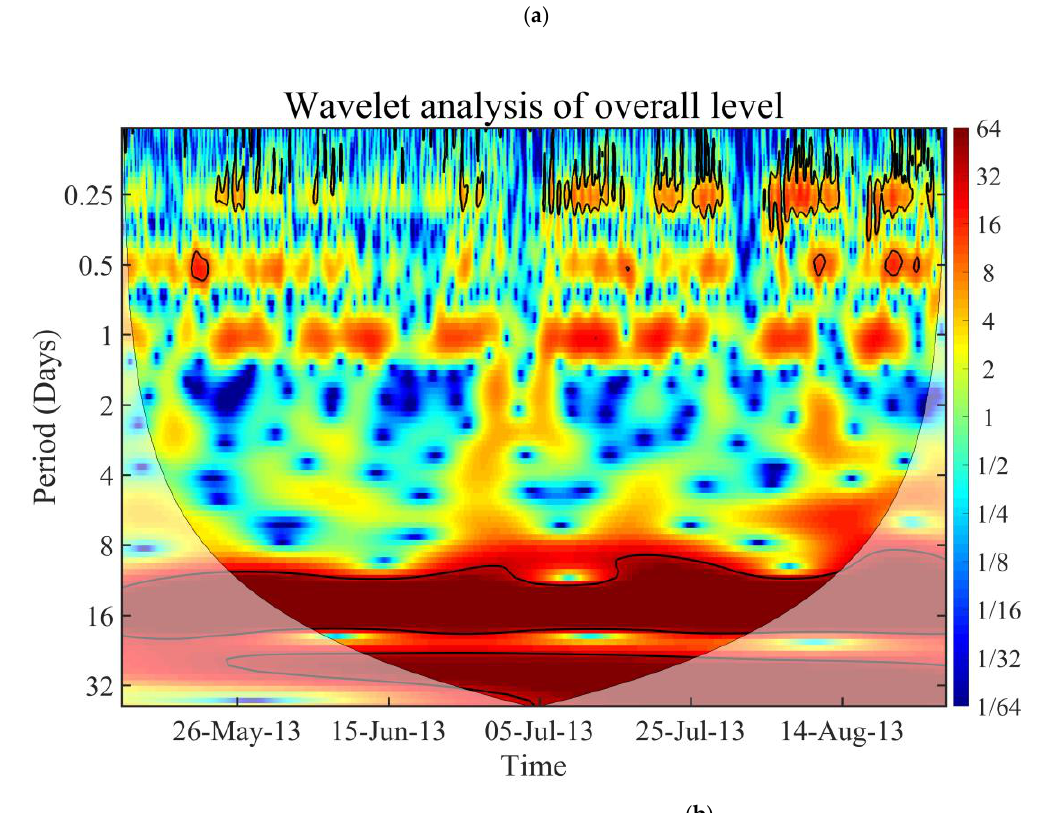
Figure 8. The continuous wavelet power spectrum of ( a ) sea level and ( b ) the overall level of underwater noise. The tick black contour designates the 5% significance level against red noise and the cone of influence (COI) where edge effects might distort the picture is shown as a lighter shade.